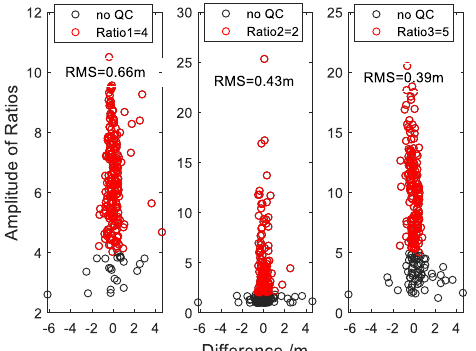
Figure 5. The relationship between three ratios and the result errors. The X axis represents the difference between the measurements of the tidal station and the water level results obtained by GNSS-IR technique.